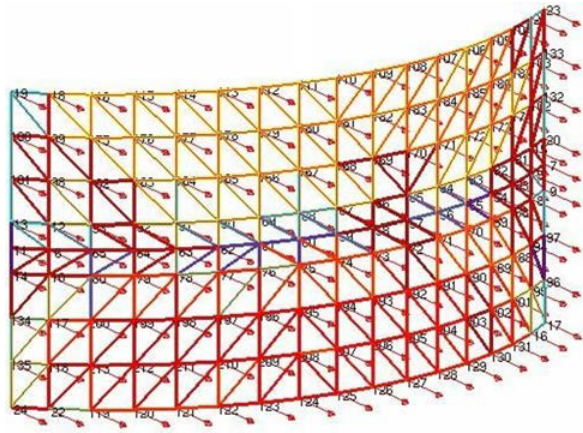
Figure 3: RTM Composite component assembly [10]